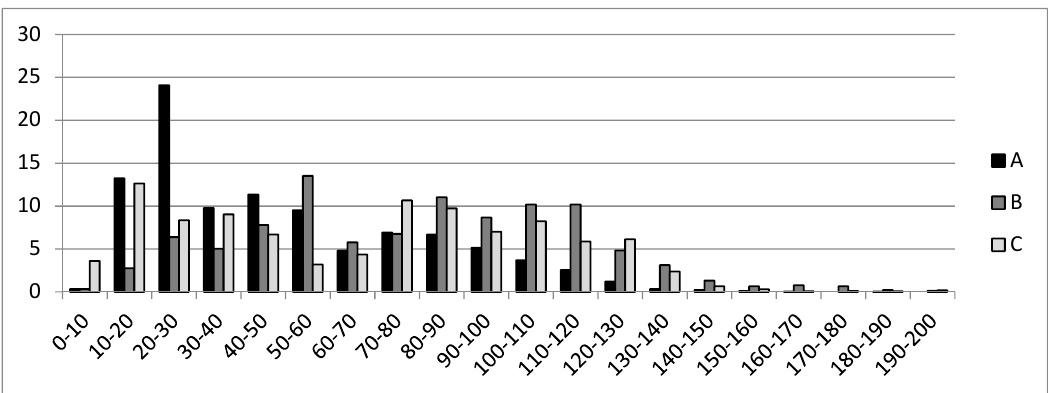
Figure 5. Area distribution forage classes (% of area vs. age classes in years).